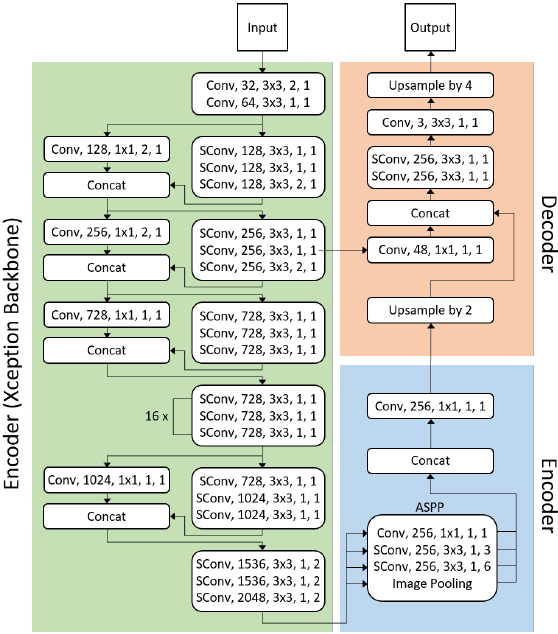
Figure 1. DLCD model. Layer descriptions contain: convolution type (Conv for regular convolution; SConv for depthwise separable convolution), number of filters, filter size, stride, dilation rate.